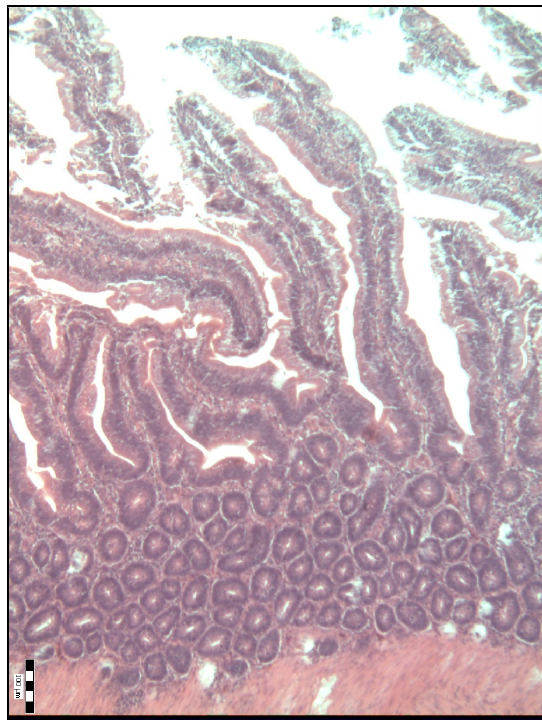
Figure 4. Histological representation of the duodenal villi of broiler chickens from the P3 experimental group of chickens (H&E; ×100).